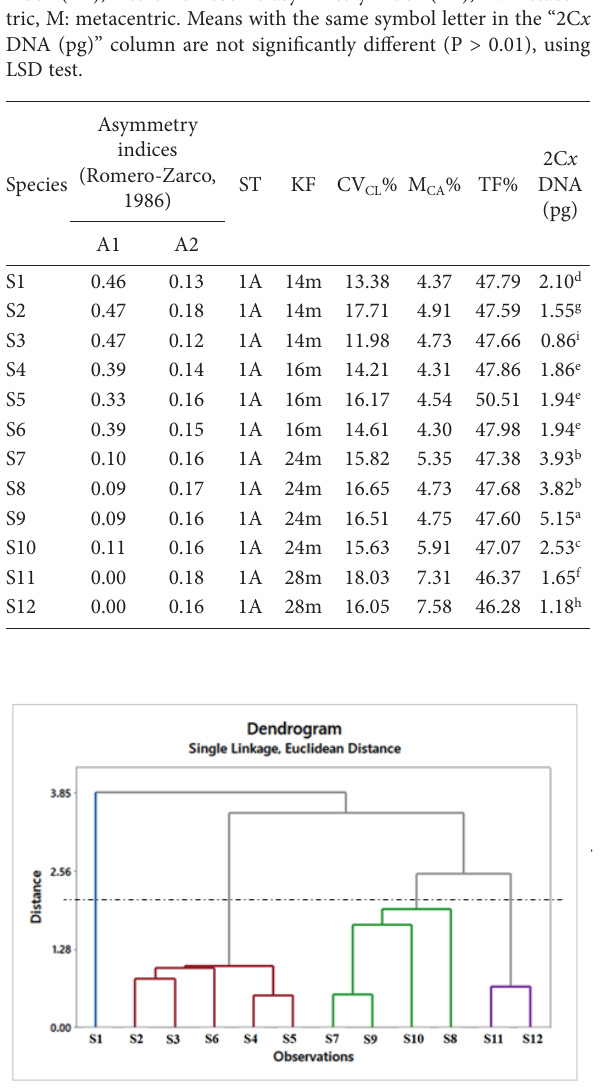
Table 3. Karyotypic symmetry formula and flow cytometric genome size of 12 berry species. Total form percentage of karyo-